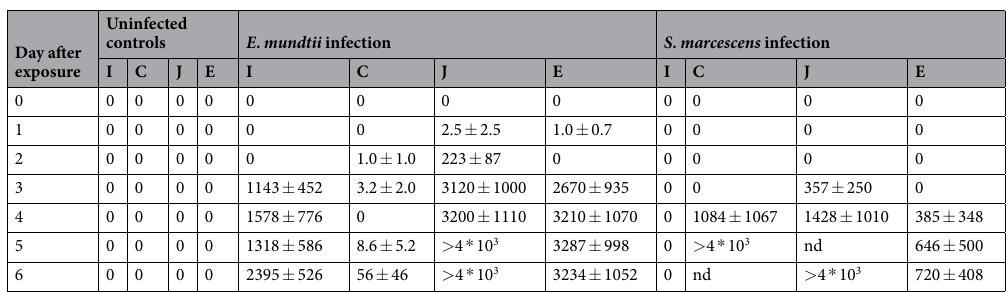
Table 1. Living bacteria in the hemolymph of the four B . mori strains after oral infection. CFUs detected in 100 µ l hemolymph are shown as Mean ± SEM or > 4 * 10 3 ; nd: not determined; I: Indian, C: Chinese, J: Japanese, E: